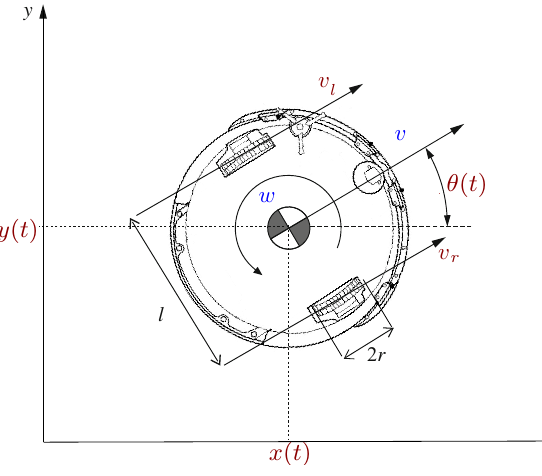
Figure 3. Differential robot